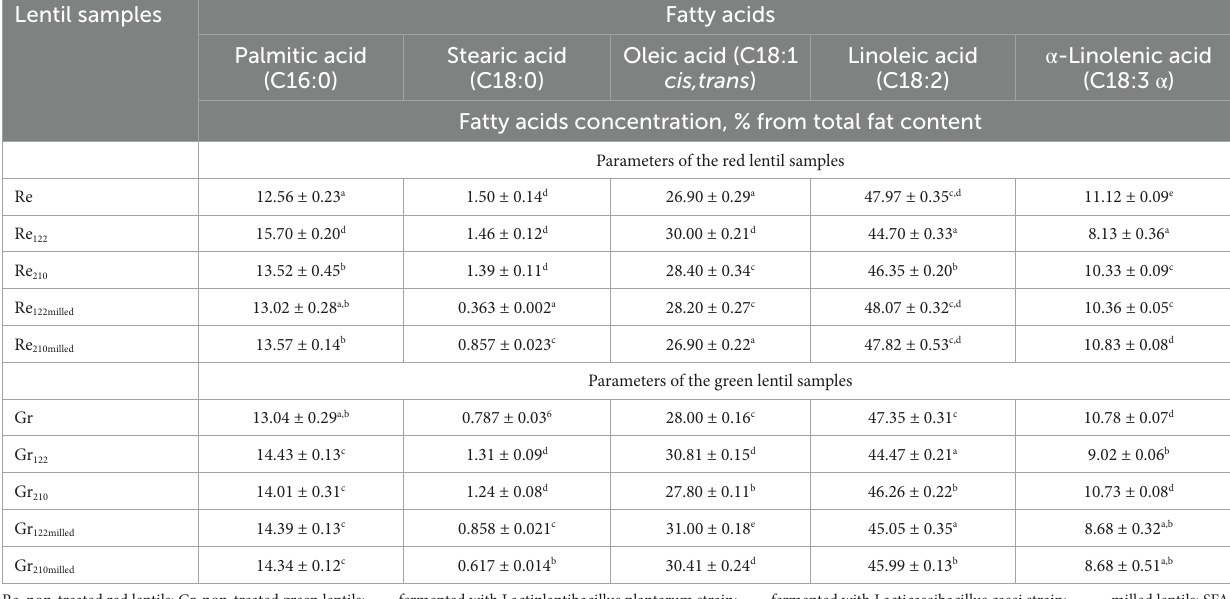
TABLE 4 Fatty acid (FA) profile in lentil samples.